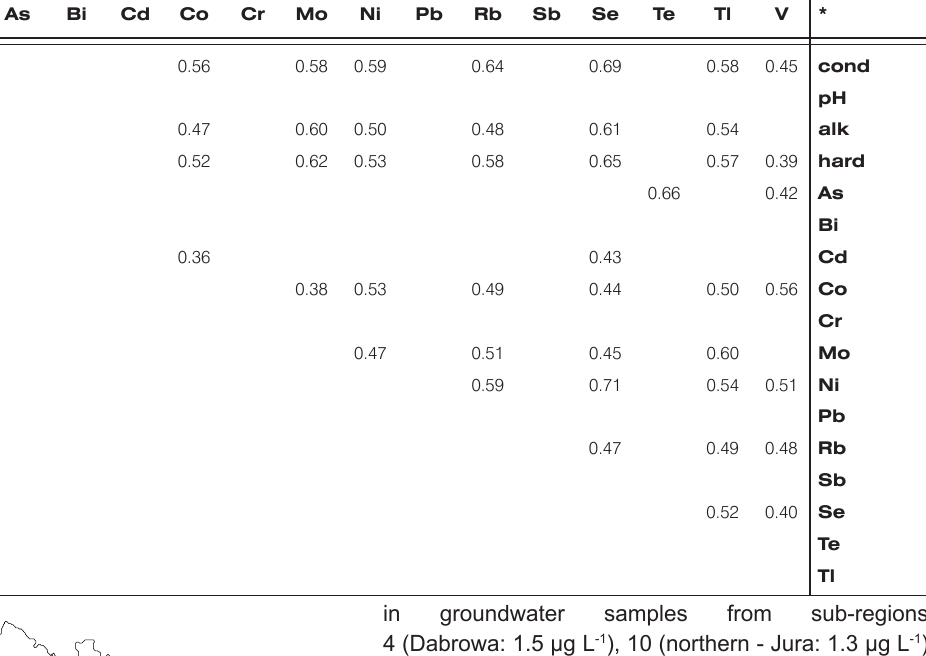
Table 3. Pearson correlation coefficients for all water samples (cond – conductivity, alk – alkalinity, hard - total hardness); * values below 0.35 were omitted